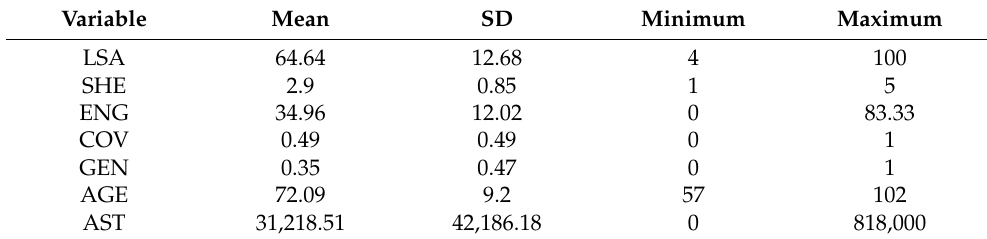
Table 2. Descriptive statistics ( n = 3879).